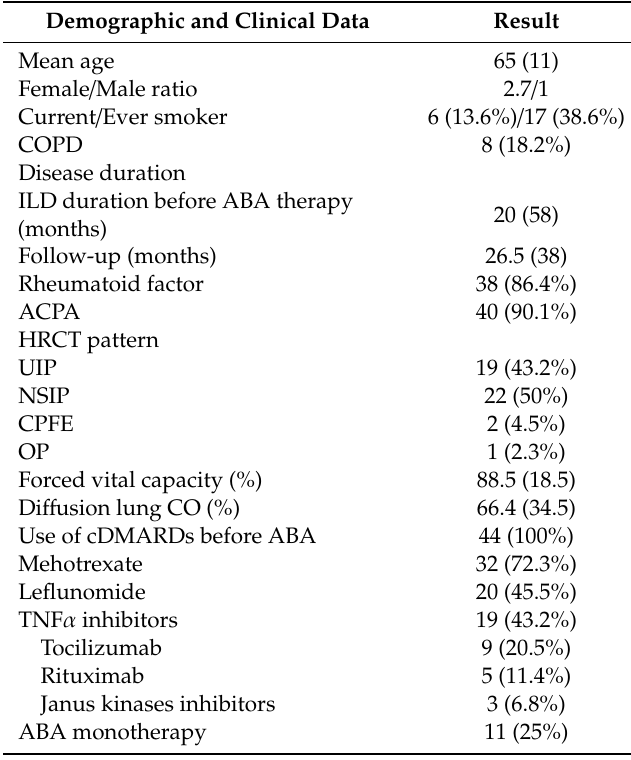
Table 1. Demographic, clinical, and serological features of patients at